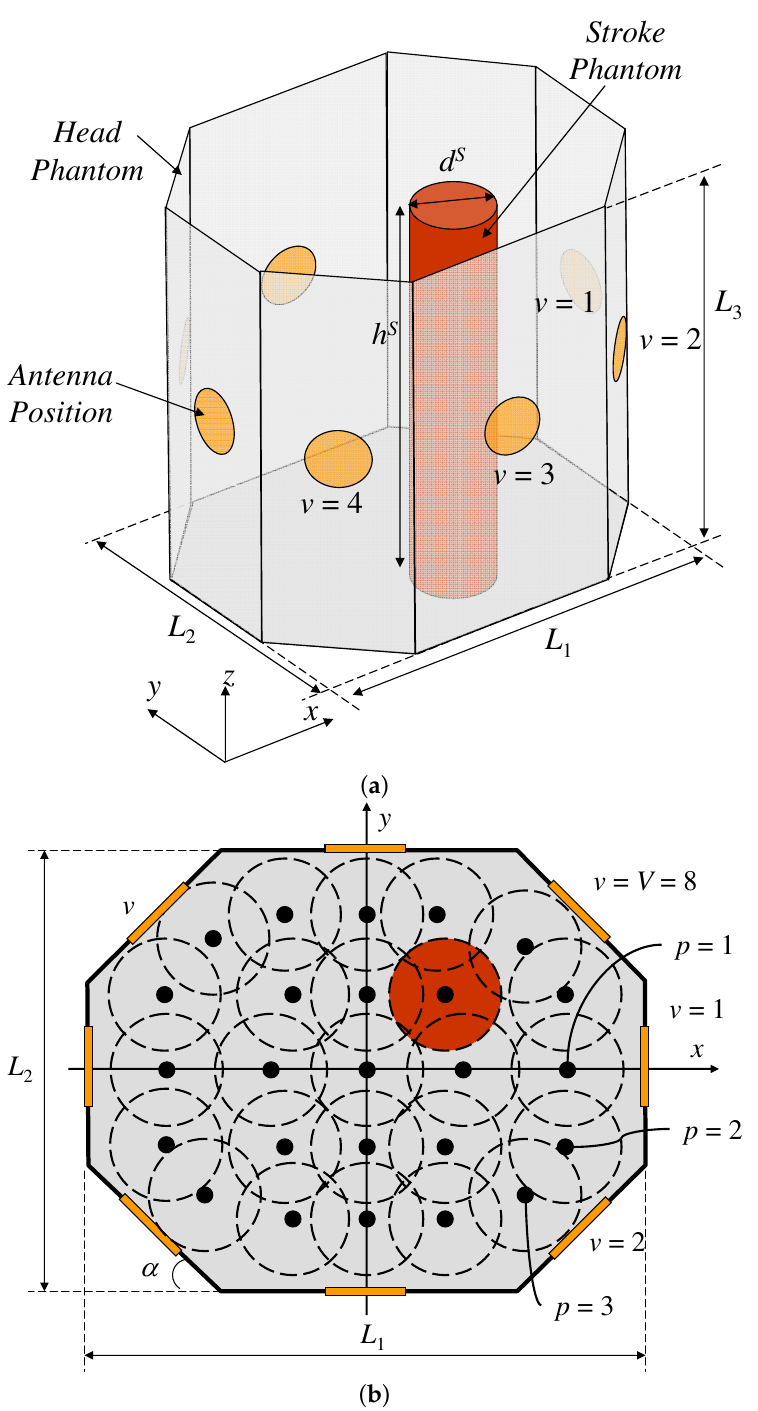
Figure 3. Experimental Assessment. ( V = 8, f 0 = 900 MHz, (cid:101) ε B = 41.8 ε 0 − j 0.97 S = 48.63 ε − j 1.28 )—( a ) Sketch of the fabricated head/stroke phantoms and ( b ) 2D map of D (cid:101) ε 0 H 2 π f 0 showing the P = 25 possible locations of the stroke phantom ( α = 45